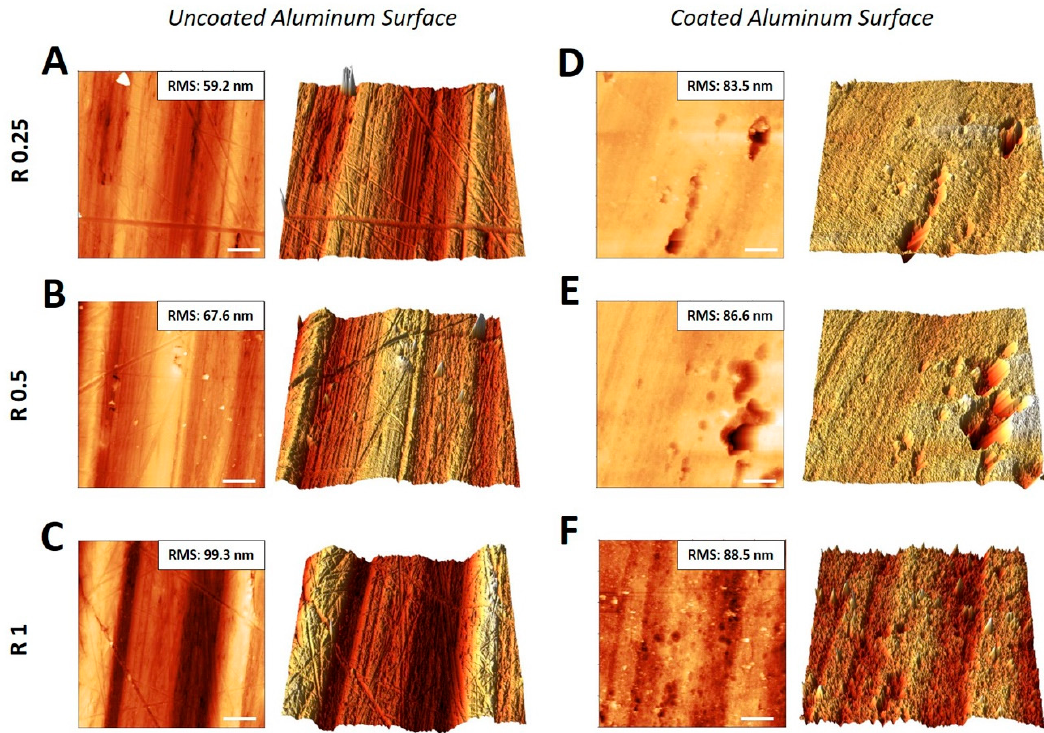
Figure 11. Atomic force microscopy topographic reconstruction of aluminum disk surface before ( A – C ) and after ( D – F ) DURALTI ® surface treatment. Each panel includes planar ( left ) and three-dimensional (3D) reconstruction ( right ). White box in the top right corner of planar reconstruction contains root mean square (RMS) roughness value. Scale bars correspond to 5 μ m.